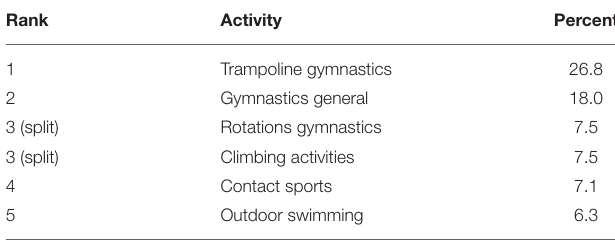
TABLE 7 | Teachers’ report on exclusion of activities by percent ( n =